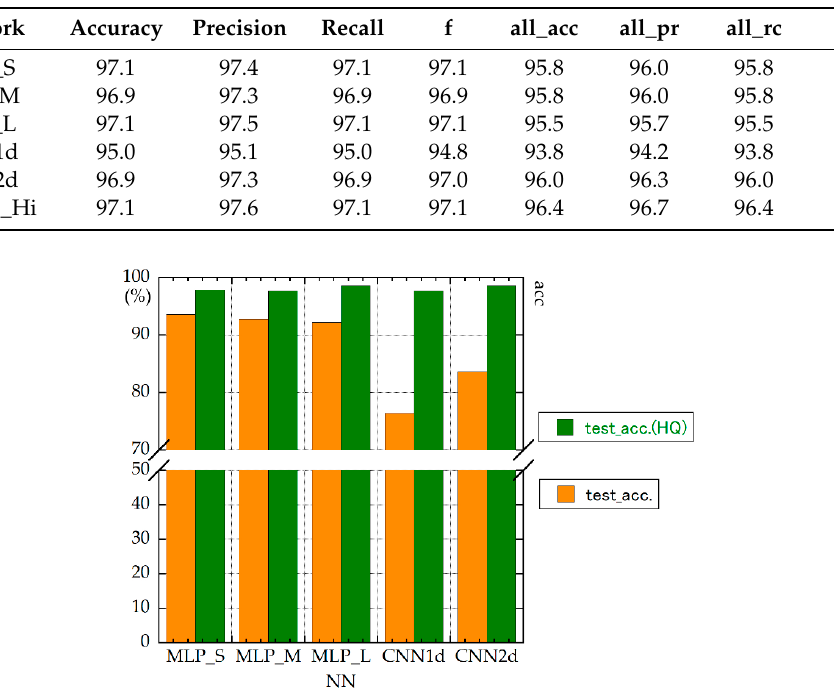
Figure 18. Test accuracies (without HQ versus with HQ).